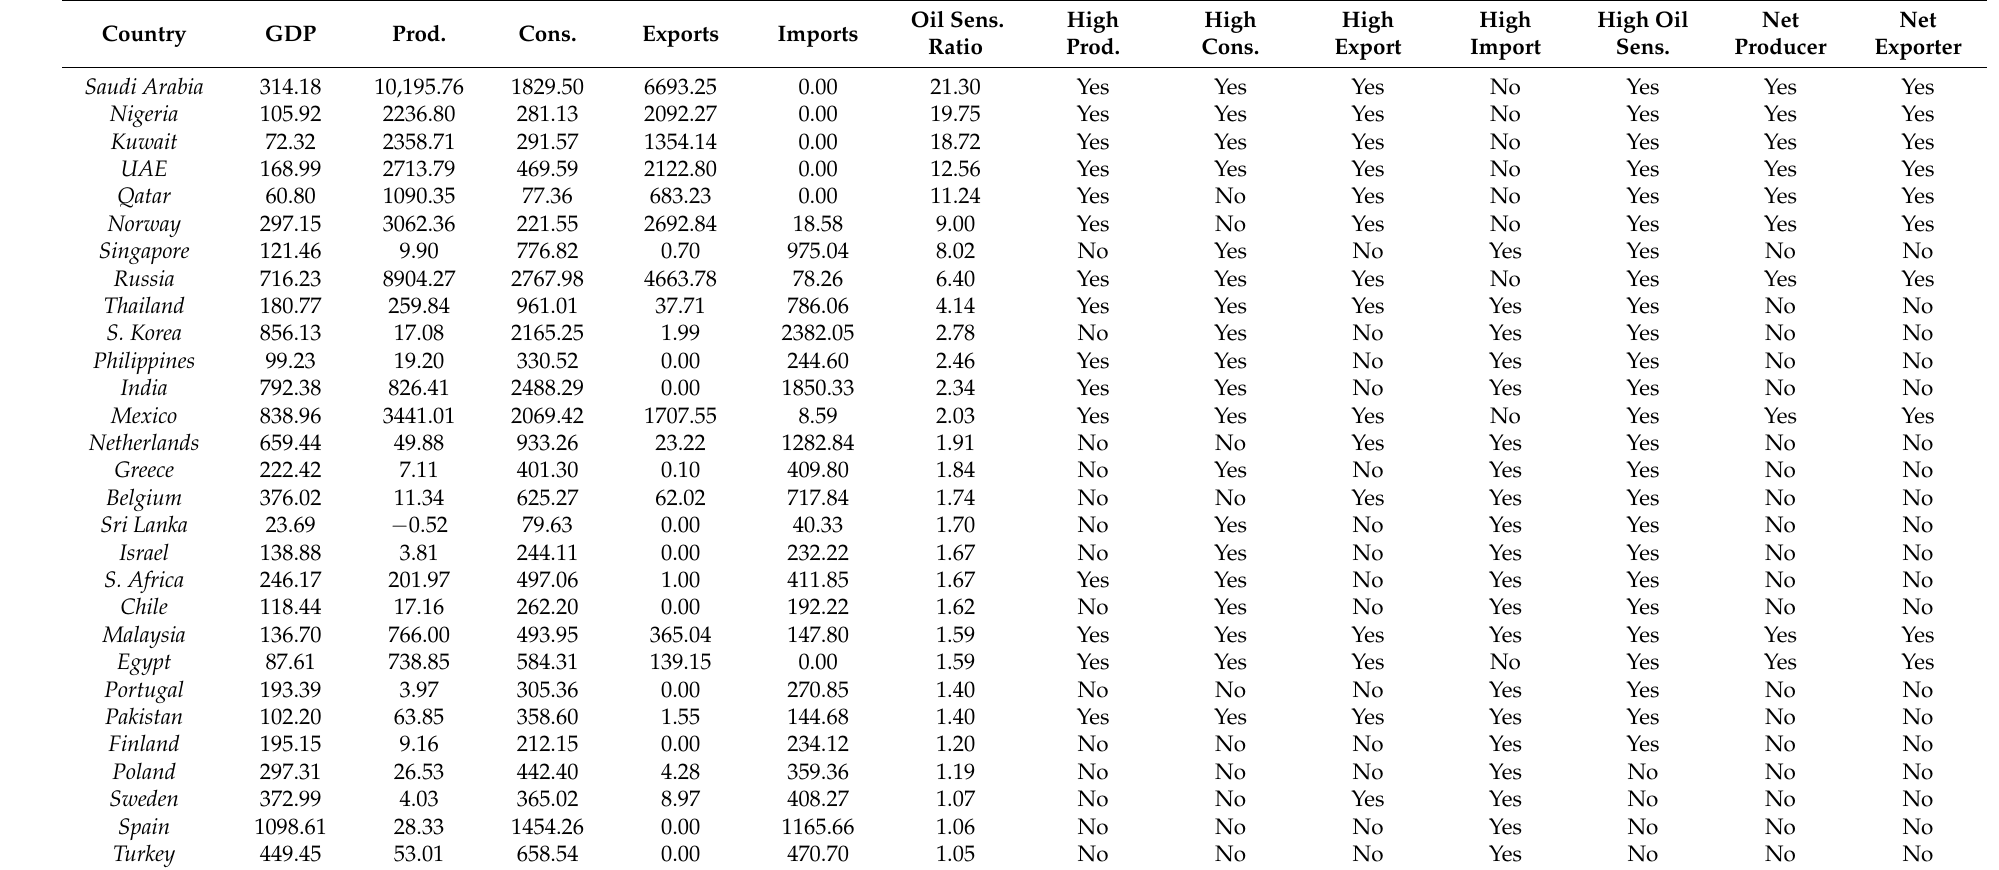
Table 1. Macroeconomic Variables and Oil Data by Country. This table reports the country medians of GDP (in constant 2005 billion USD), production, consumption, and exports and imports of crude oil (in thousand barrels per day) over the period 1995 to 2015. It also reports the median of the oil sensitivity ratio, which is defined as the absolute value of the difference in oil exports and imports scaled by GDP in constant 2005 billion US dollars. The last six columns are indicators of the variables, production, consumption, export, import, and oil sensitivity ratios that are set to “Yes” if the country median of the variable is above the median of all countries for that variable and “No” otherwise. The indicators for net producers and net exporters are reported as “Yes” if the country is a net producer or net exporter by median, respectively, and “No” otherwise. Country GDP Prod. Cons. Exports